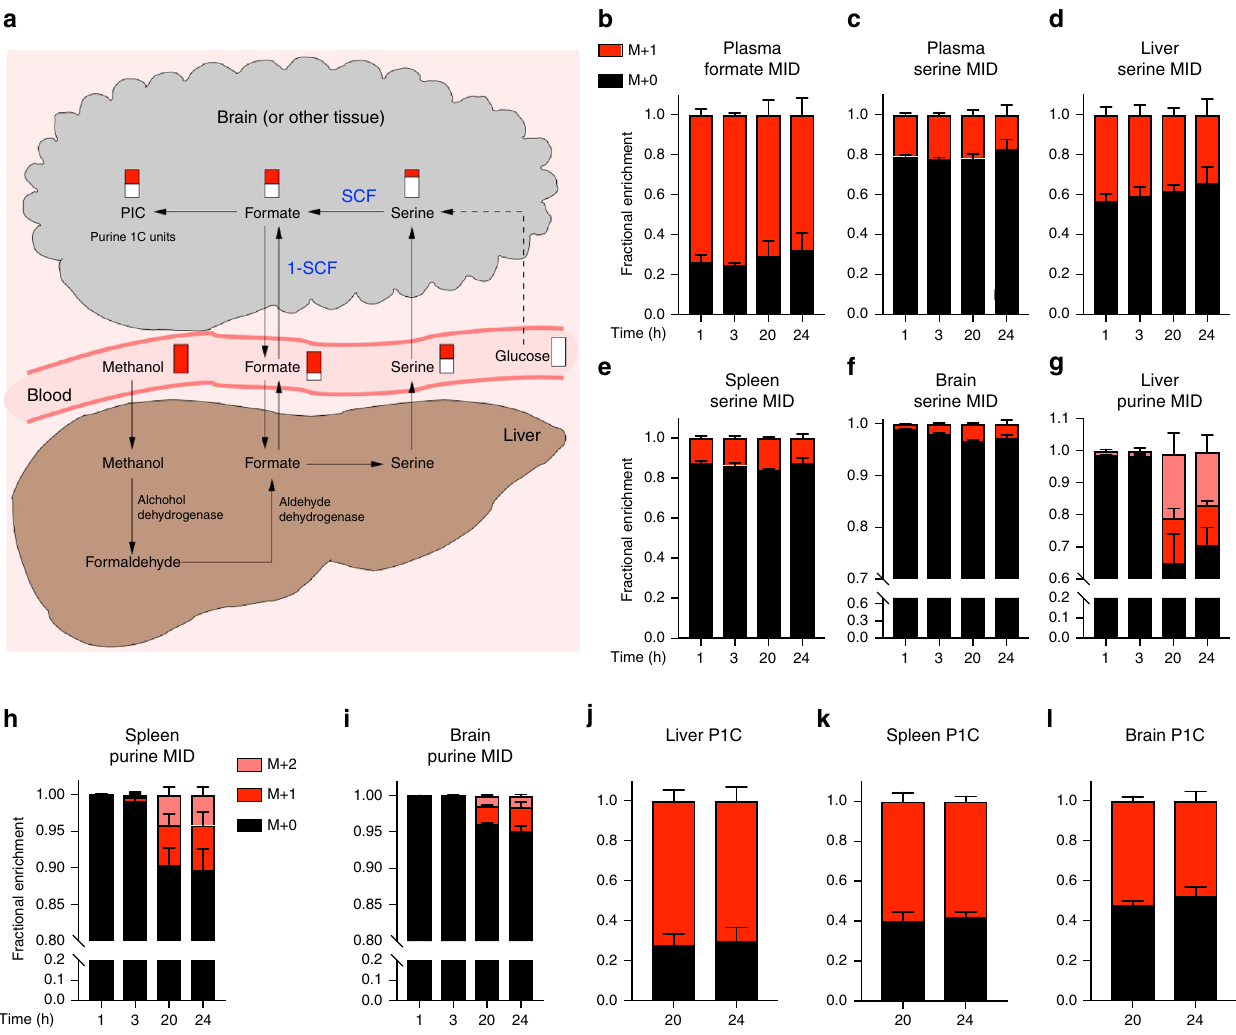
Fig. 2 13 C – MeOH protocol to quantify serine catabolism to formate in vivo. a Diagram tracing the metabolism of 13 C methanol and its intersection with serine catabolism to formate. b – i time-dependent Mass Isotopomer Distribution (MID) of different metabolites in different tissues after a 3 g/kg IP injection of 13 C – MeOH. b , c Plasma formate and serine MID. d – f Serine MID in liver, spleen and brain. g – i Purine MID in liver, spleen and brain. j – l P1C MID in total purines in liver, spleen and brain. Results were obtained from four mice per time point ( n = 4). Error bars denote s.e.m